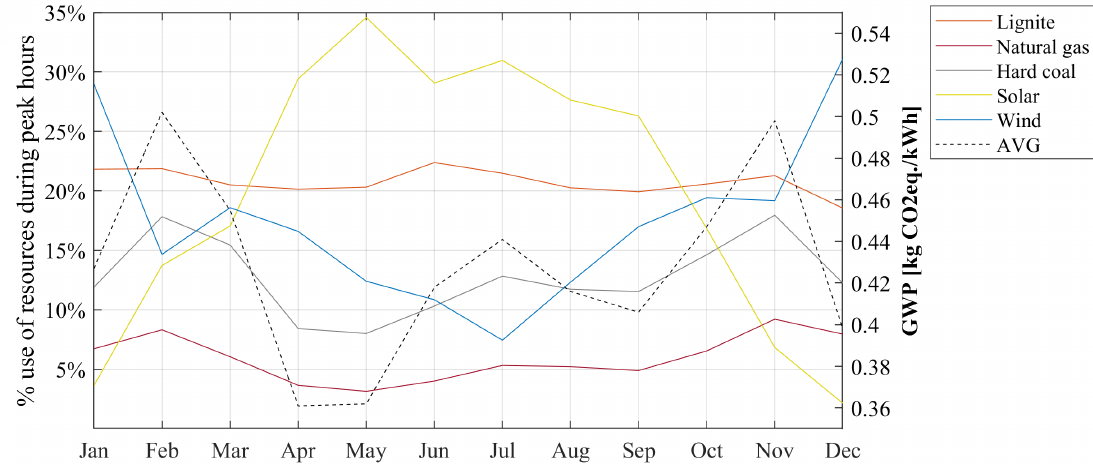
Figure 6. Percentage use of resources throughout the year compared with monthly GWP in Germany, both related to peak